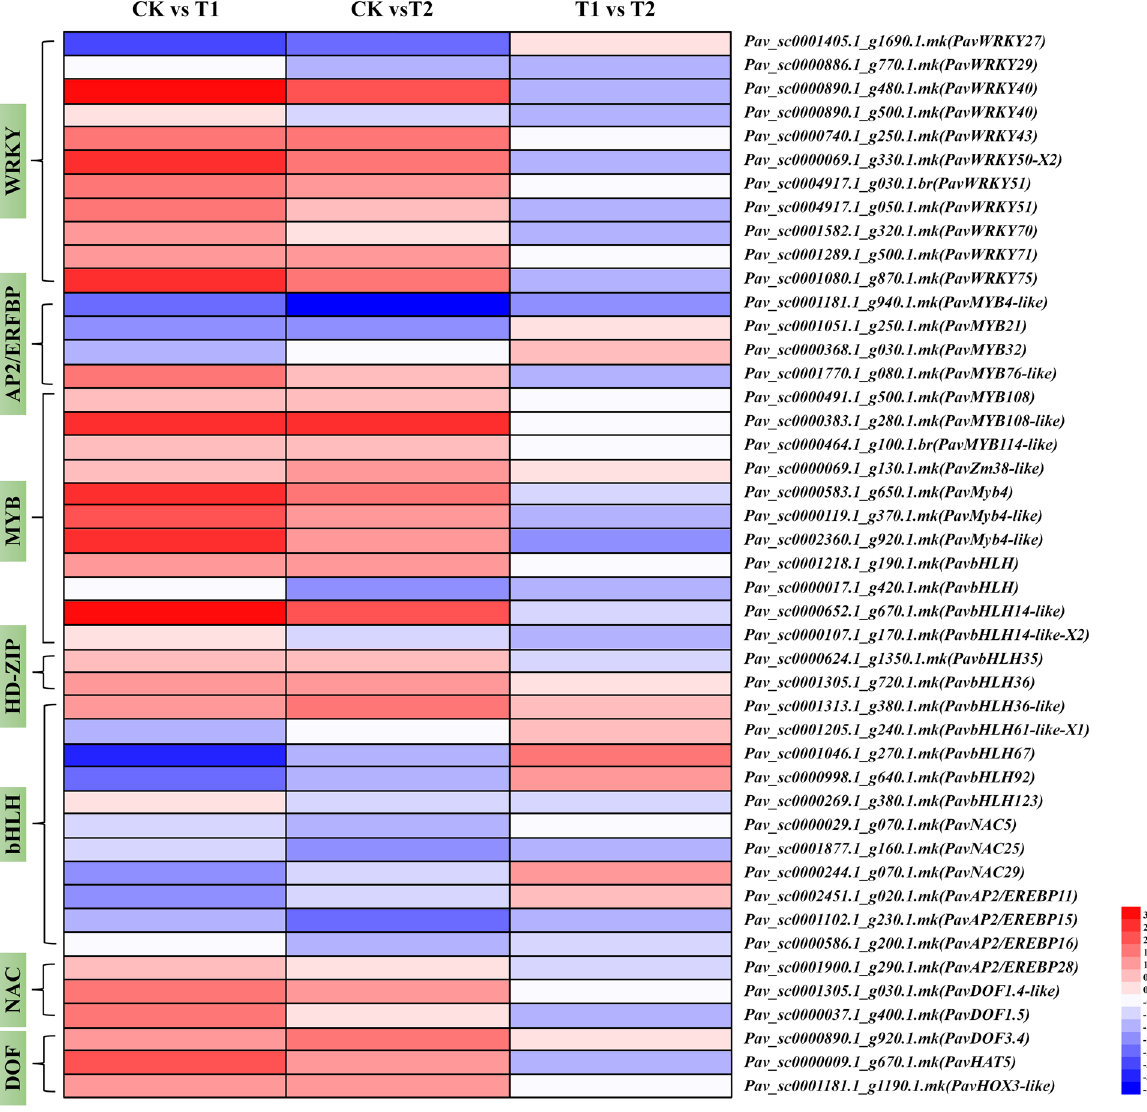
Fig. 10 Expression profiles of DEGs related to stress associated transcription factors, shown using a heatmap. The scale of color intensity is shown in the lower left quarter of heatmap, representing the log 2 fold-change values. Fold-change refers to the ratio of gene expression levels in cherry rootstock leaves between control (CK) and treatments